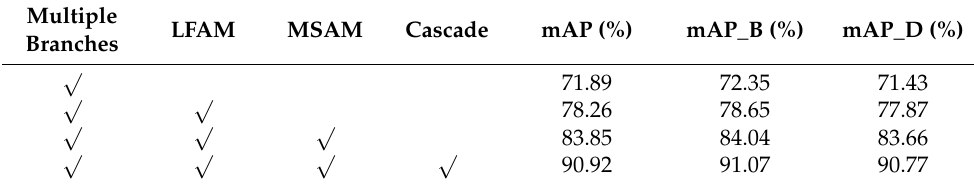
Table 4. Effects of each component in CrdNet. Results are reported on HL2019 test set.